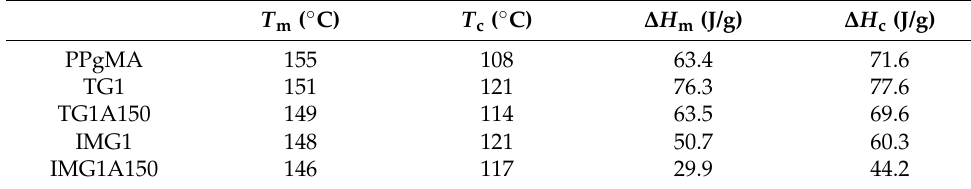
Table 5. Melting and crystallization properties of thiophene bismaleimide